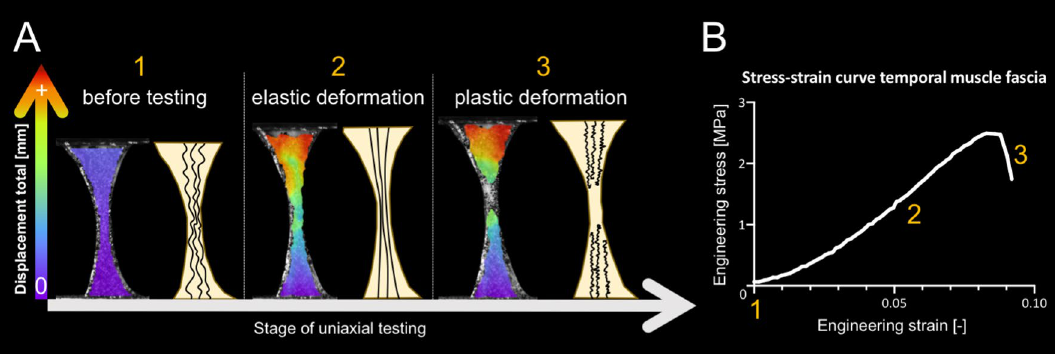
Figure 3. Images of a representative temporalis muscle fascia (TMF) sample at different stages of uniaxial tensile testing with a schematic depiction of the related collagen behavior and the related stress–strain curve are displayed. ( A ) The TMF sample is shown before the load is applied (1). The collagens within the sample are in a crimping state. A uniform diminution occurs in the tapered area of the tested sample once a load is applied. When the sample is elastically deformed the collagens are stressed (2). When the TMF is stressed beyond its yield point, it will deform plastically, schematically represented by collagen rupture (3). ( B ) The related stress– strain curve of the sample shown in A is depicted. The orange numbers correspond to the stages of testing, equally represented by orange numbers in A between the left and right TMF were performed only for cadavers for which samples were obtained from both sides of the same cadaver using a Friedman test. This was done to exclude a potential bias due to other factors such as sex or PMI. No post hoc test has been applied, assuming the hypothesis-generating nature of this study. Age correlations of the biomechanical properties were performed for the entire age range as well as separately for the following age ranges as done previously 24 : infancy/adolescence (0–18 years), early to late middle adult- hood (19–43 years) and older adulthood people (44–93 years). Pearson and Spearman correlation coefficients were reported for normally and non-normally distributed values, respectively. P values equal to or smaller than 0.05 were considered statistically significant. Mean values ± standard errors of the mean are reported in the text. Histology.